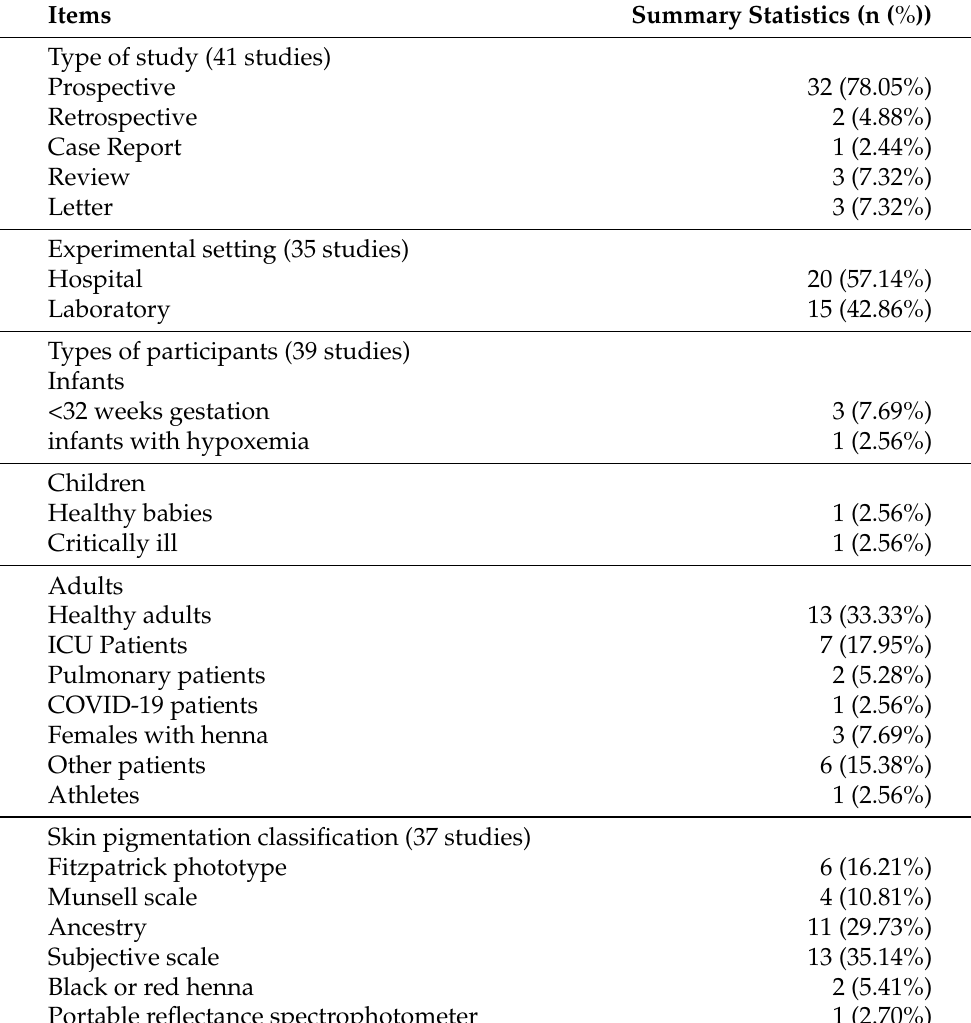
Table 4. Summary characteristics of the selected